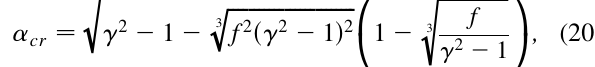
We assume that at the wiggler entrance z ¼ 0 , where the wiggler field tends to zero, the electrons move along the wiggler axis, i.e., in the variables used they are in the with the increase in the wiggler field amplitude (cid:4) due w to the adiabatical invariant preservation (19), the electrons stay in the equilibrium state, which shifts along the ordi- Þ . This nate (i.e. along the p axis) in the plane ð p ; p 1 1 2 corresponds to the excitation of the electron oscillation at the bounce frequency. For a strong axial magnetic field f > ffiffiffiffiffiffiffiffiffiffiffiffiffiffiffi p ¼ 0 ) when there is a single (cid:3) 2 (cid:2) 1 (i.e. f > f at (cid:4) cr w equilibrium state II positioned on the positive semiaxis p > 0 [Fig. 1(a)], the above process of pumping the 1 (cid:8) bounce oscillations takes place up to any value of (cid:4) . In p ffiffiffiffiffiffiffiffiffiffiffiffiffiffiffi w (cid:3) 2 (cid:2) 1 bounce contrast, for a weak magnetic field f < oscillations are also excited for the electrons with the growth of (cid:4) but only at the initial stage. In this case, on w the phase plane the electrons are in the equilibrium state I < 0 which are positioned on the negative semiaxis p 1 (cid:8) [Fig. 1(b)]. However, increase in the wiggler field results in decrease of the parameter f [see formula (11)] and, cr finally, when the wiggler field reaches the critical value, ffiffiffiffiffiffiffiffiffiffiffiffiffiffiffiffiffiffiffiffiffiffiffiffiffi ffiffiffiffiffiffiffiffiffiffiffiffiffiffiffi